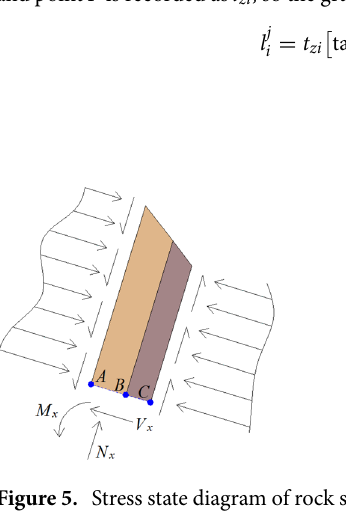
Figure 5. Stress state diagram of rock stratum unit above the failure